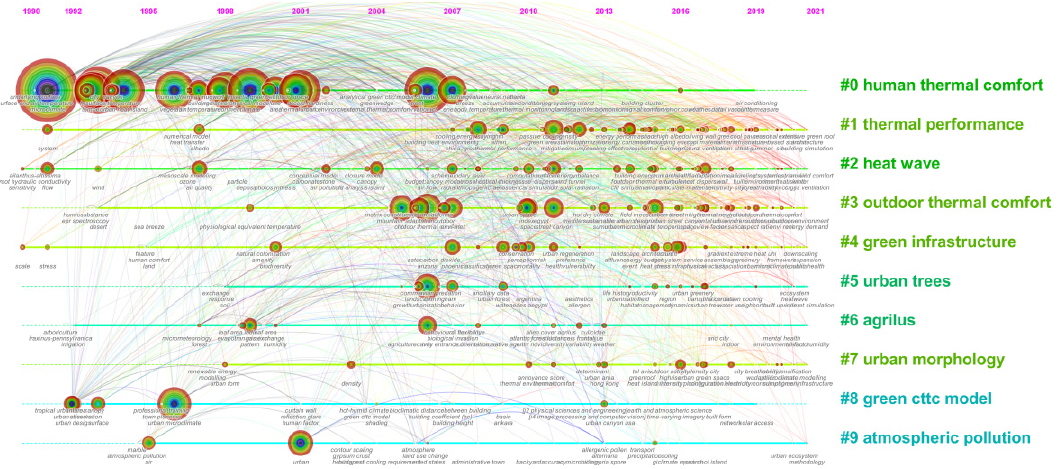
Figure 8. Time-zoned axial mapping of urban microclimate studies (top ten categories).